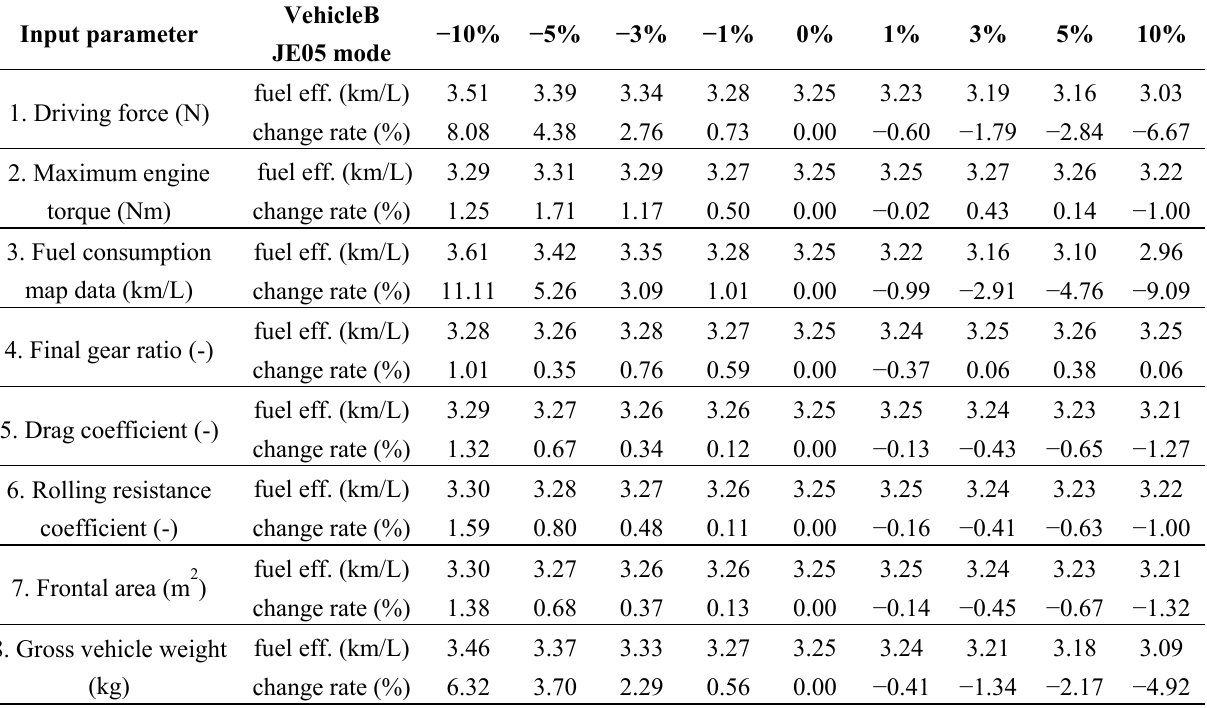
Table 11. Relative changes of the predicted fuel efficiency results compared to baseline case—case